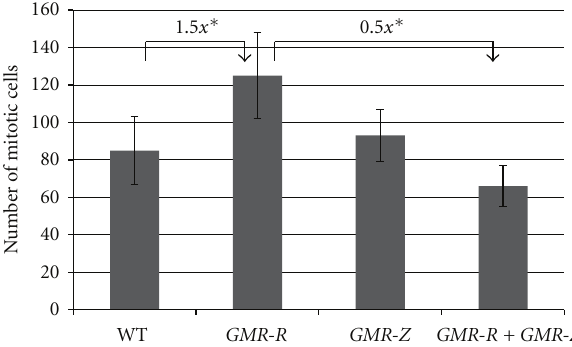
Figure 5: Expression of Z counteracts the overproliferation pheno- type within GMR-R eye discs. Third instar eye imaginal discs from wild-type (WT), GMR-R3, GMR- Z, and GMR-R/GMR- Z larvae were stained with anti-phospho-histone-H3 (Ser 10) antibody. The number of positively stained cells within the furrow or posterior to the furrow was counted. Cells from approximately 12 discs were counted for each genotype. Error bars show the standard error; ∗ indicates a P value < 0.0001. GMR-R3 eyes. GMR-R flies, and especially GMR-R3 flies, had a darker red eye color than wild type (data not